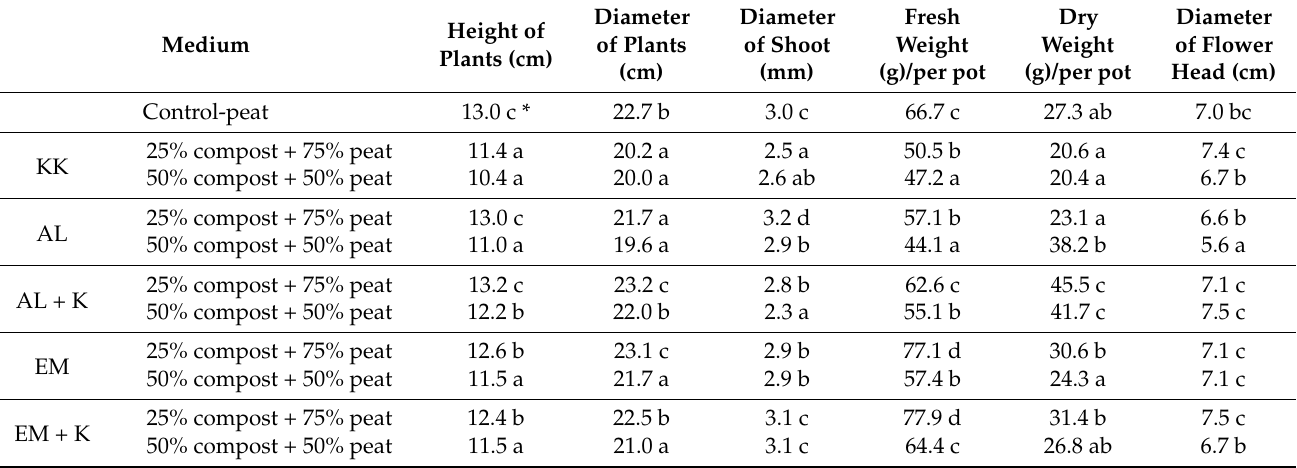
Table 6. The influence of medium on morphological features of